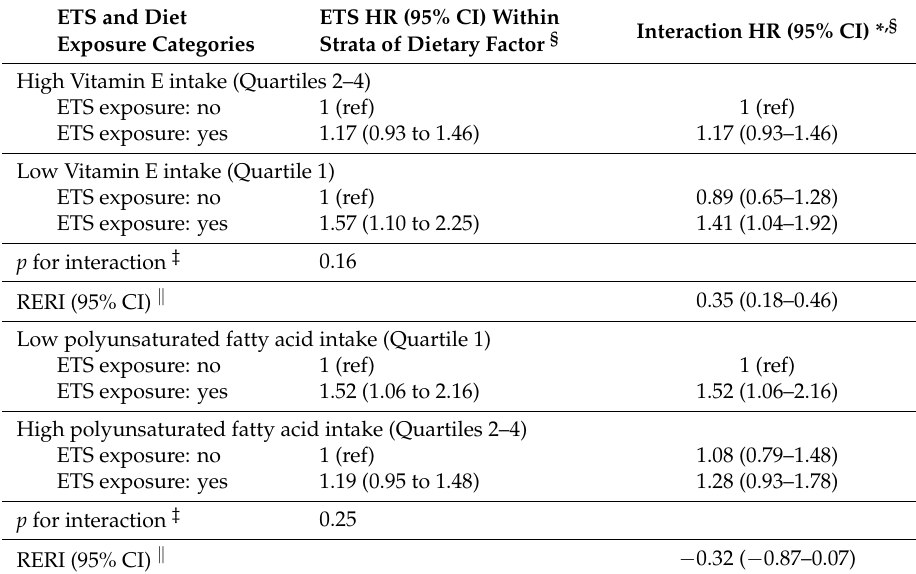
Table 3. Measure of the effect of ETS exposure on CVD incidence by Vitamin E and polyunsaturated fatty acid intake, Strong Heart Study ( n =